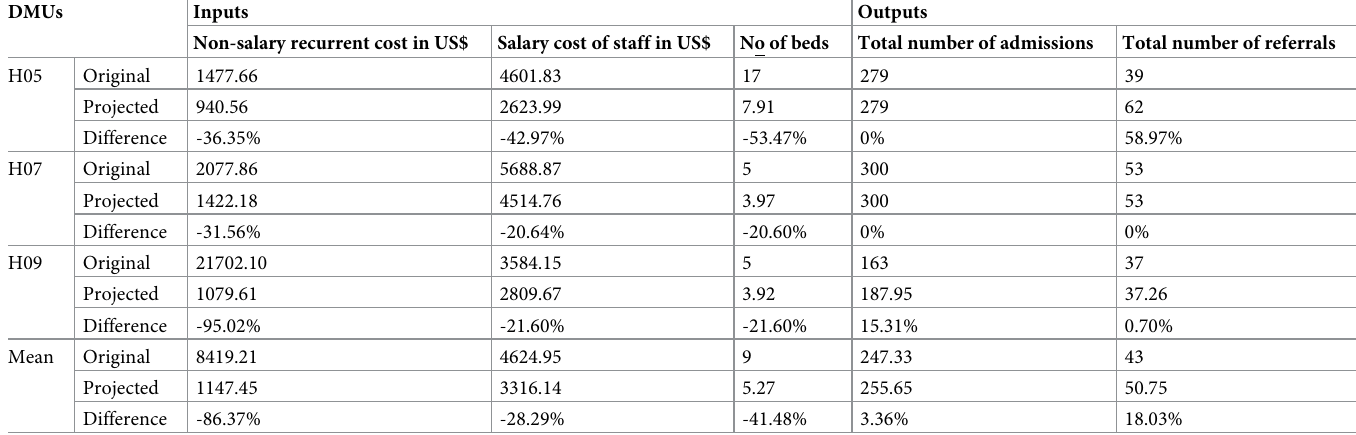
Table 4. The projection of input reduction and output escalation to make the inefficient primary hospitals efficient in three zones of Northwest Ethiopia, 2021 (N = 15 DMUs). DMUs